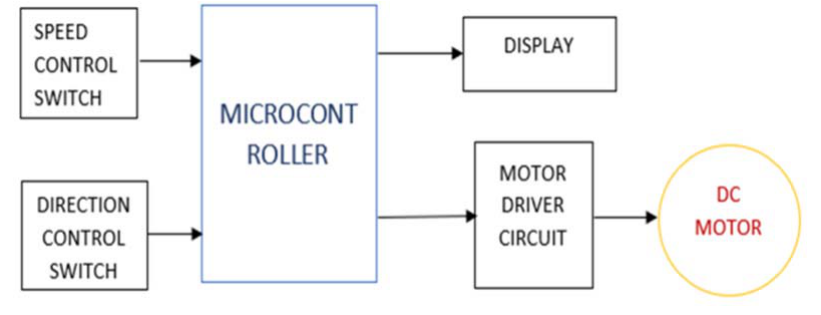
Figure 1. Block diagram of proposed